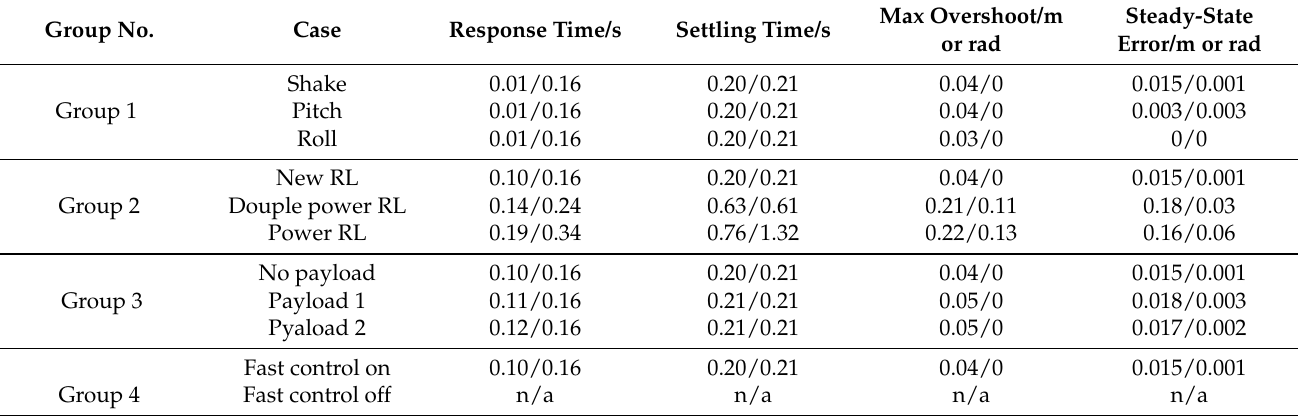
Table 4. Dynamic specifications for four groups of